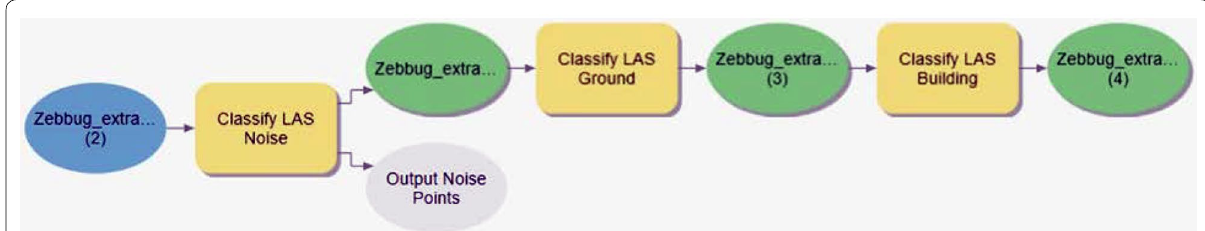
Fig. 2 ModelBuilder for classifying lidar data in Las